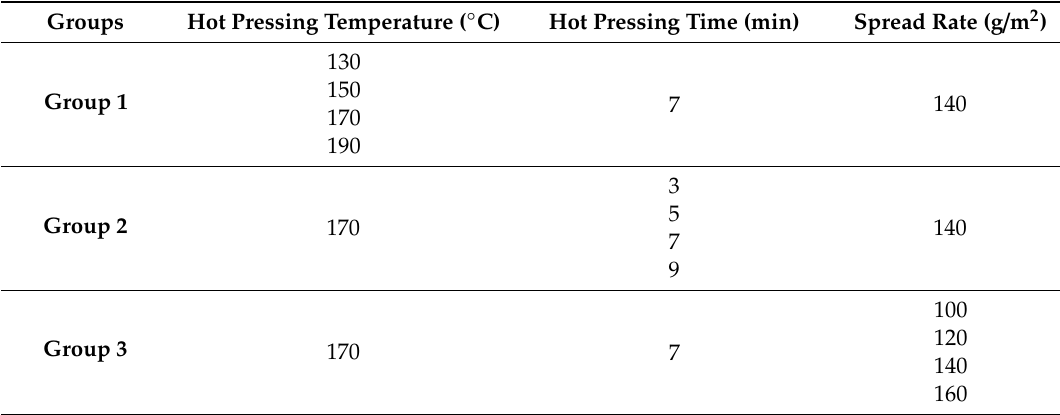
Table 1. Manufacture conditions of the plywood bonded by SADP